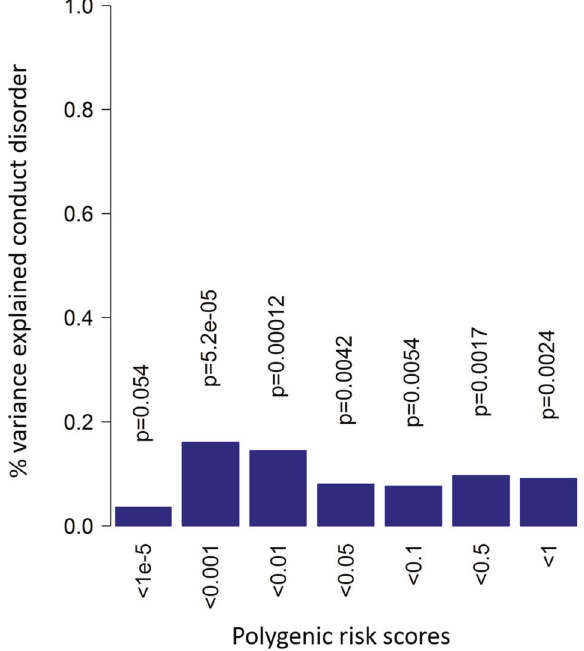
Fig. 3 Proportion of explained variance (vertical axis) in retro- spective adolescent CD (two-sided tests). Blue bars indicate positive correlation with the conduct disorder